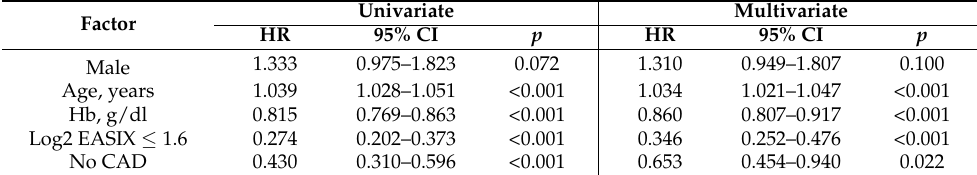
Table 3. Univariate and multivariate Cox analysis for overall survival in all COVID-19 patients. Factor